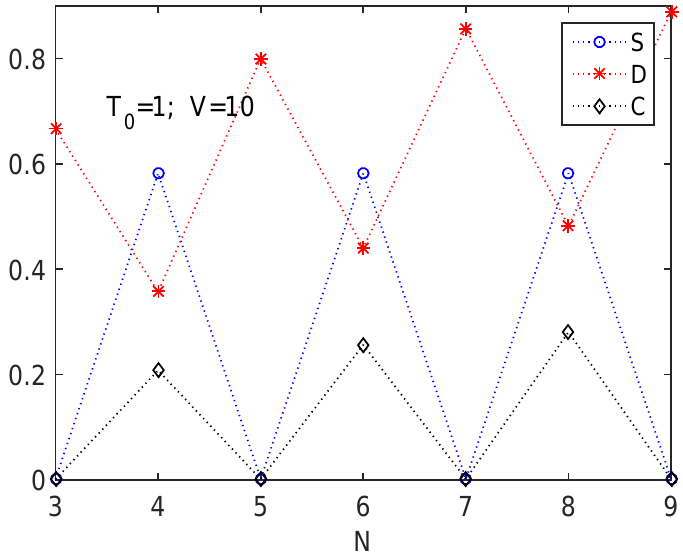
Figure 1. Statistical quantifiers (entropy S , disequilibrium D , and complexity C versus fermion- number N ) at temperature = 1 Kelvin and coupling constant V = 10. The even-odd staggering effect is plainly